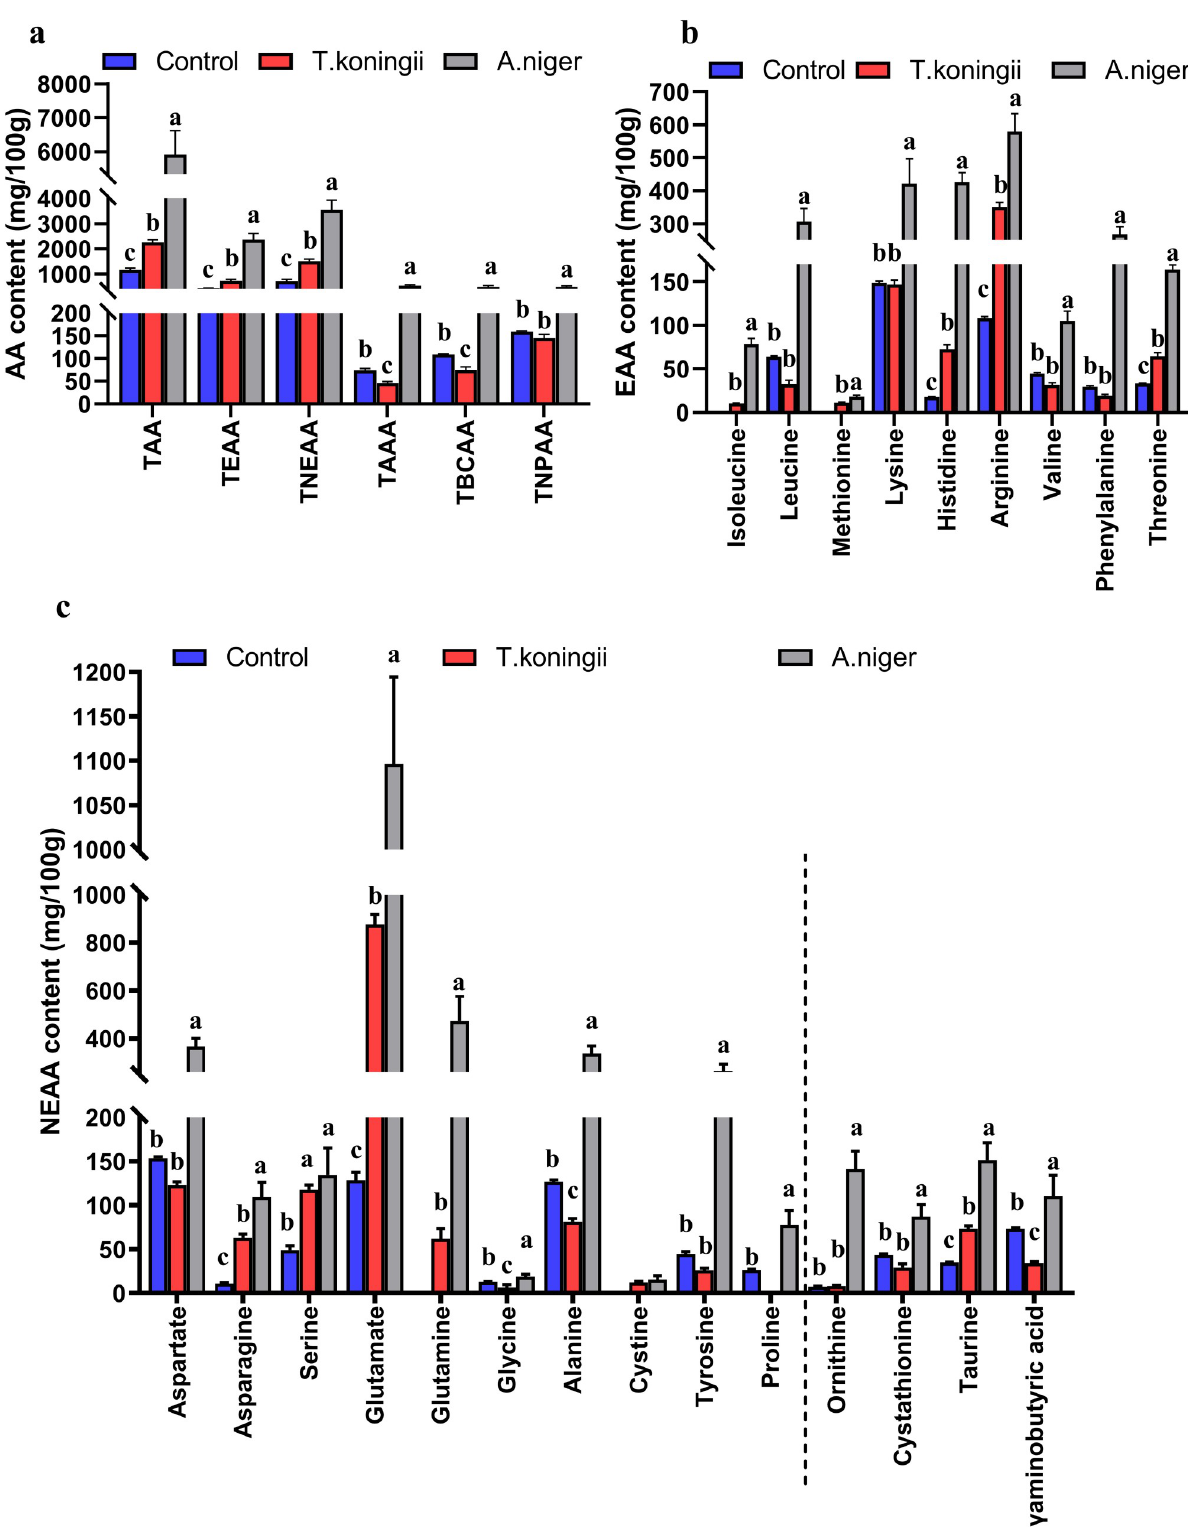
Fig 2. Free amino acids in the fermented tea dregs. TAA, total amino acids; TEAA, total essential amino acids; TNEAA, total non-essential amino acids; TAAA, total aromatic amino acids; TBCAA, total branched-chain amino acids; TNPAA, total non-protein amino acids. Values with the same letters were not significantly different ( P <